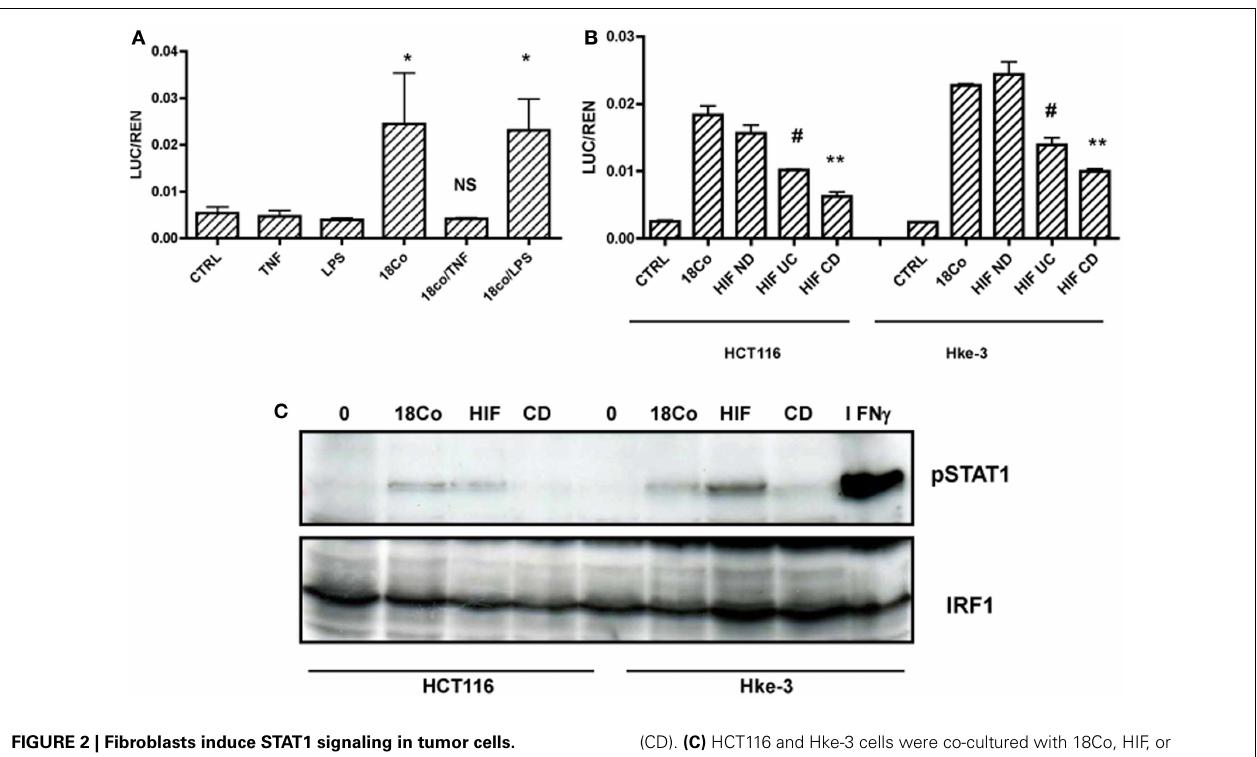
FIGURE 2 | Fibroblasts induce STAT1 signaling in tumor cells. (A) HCT116 cells transfected with GAS-LUC were treated as indicated, (B) HCT116 and Hke-3 cells were transfected with GAS-LUC and were co-cultured with 18Co cells, fibroblasts isolated from a normal donor (HIF ND), a patient with ulcerative colitis (HIF UC) or Crohn’s disease